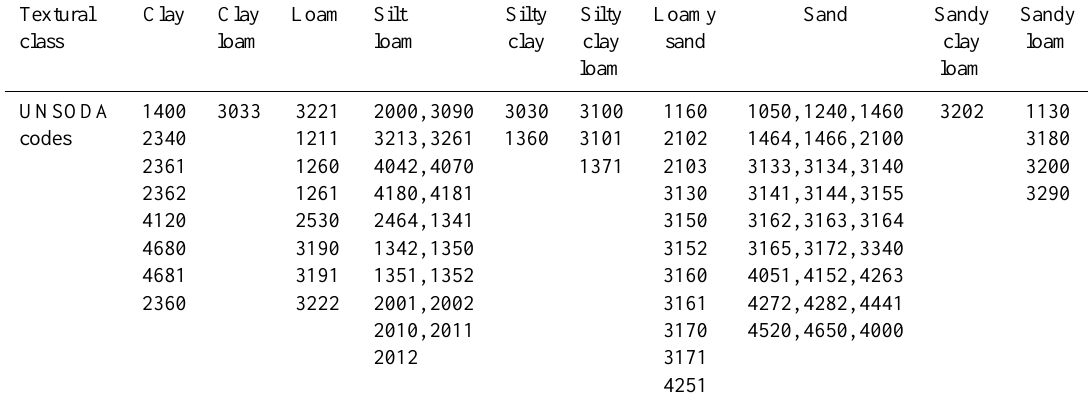
Table 1. Textural classes and UNSODA codes for soils used for testing and evaluating the approach. Textural Clay Clay Loam Silt Silty Silty Loamy Sand Sandy Sandy class loam loam clay clay sand clay loam